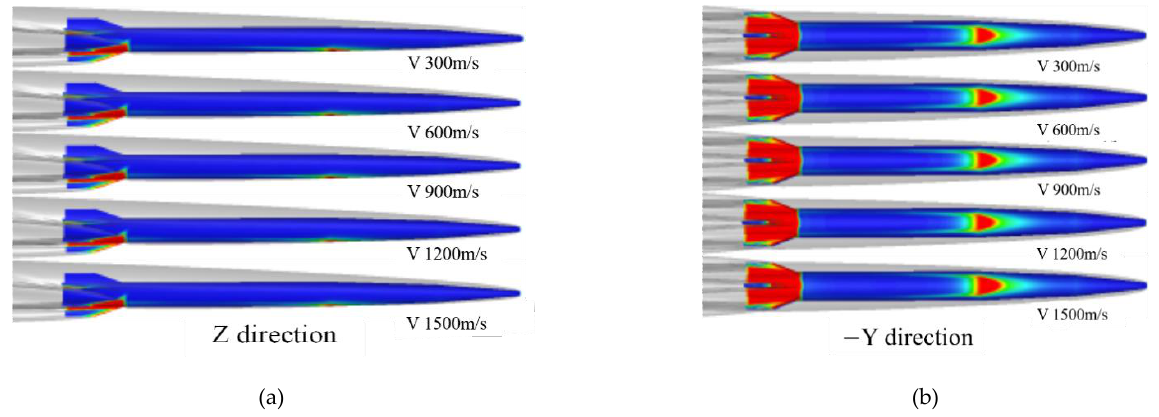
Figure 10. Cavitation morphology with different flow speeds in the directions of ( a ) Z and ( b ) – Y, respectively. (attack angle 2°).